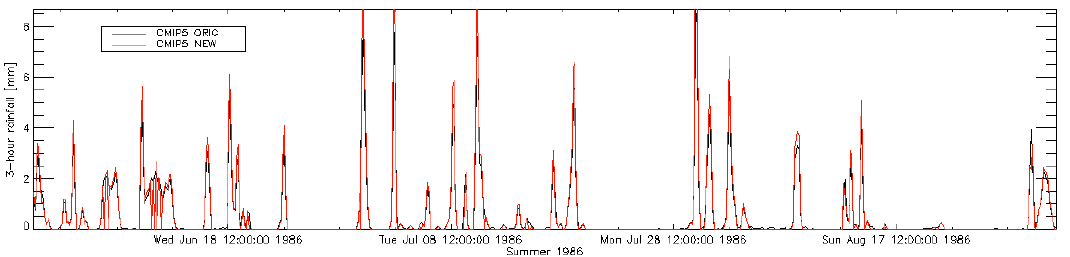
Figure 7. Precipitation time series from the MIROC-ESM-CHEM GCM after the processing step described in the main text. The black line denotes the original rainfall amounts, and the red line is the downscaled